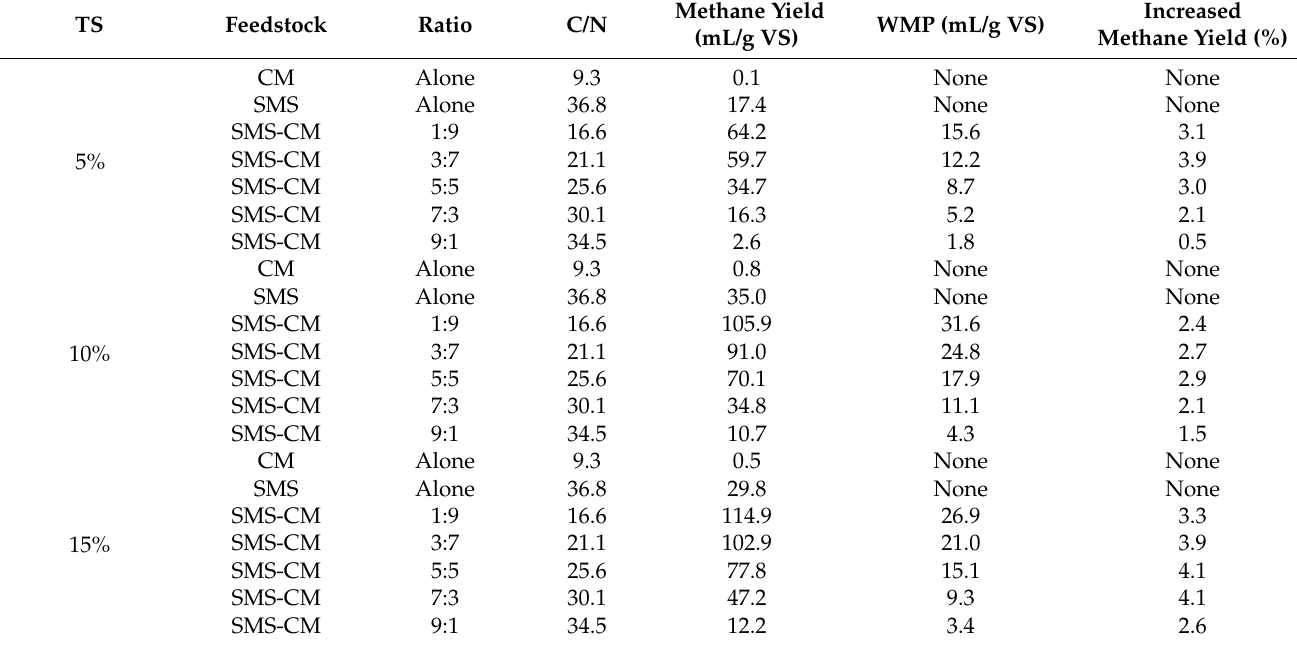
Table 5. Synergetic analysis of methane yield from digestion of